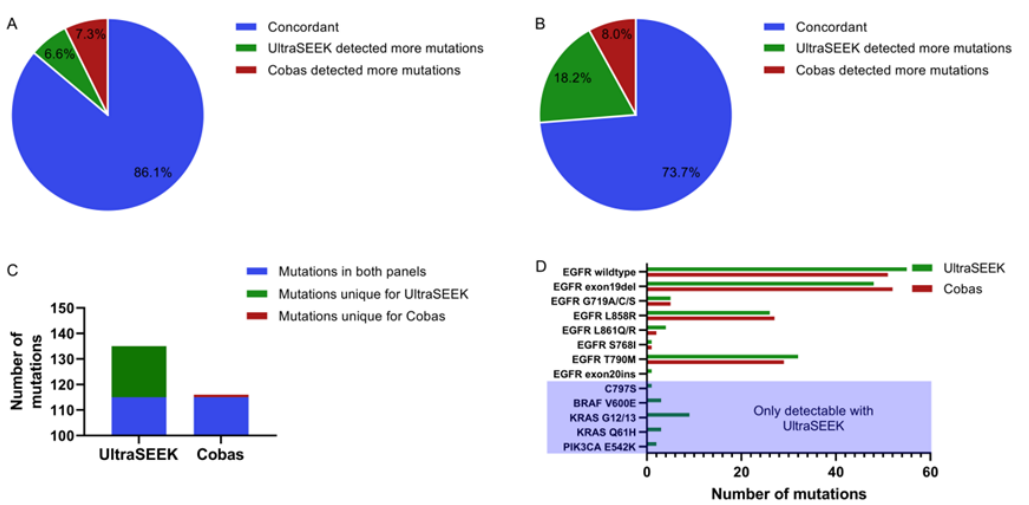
Figure 1. Comparison of mutation detection between UltraSEEK ™ and Cobas ® . Pie charts representing the samples which were concordant between UltraSEEK ™ and Cobas ® (blue), samples in which UltraSEEK ™ detected more mutations (green), and samples in which Cobas ® detected more mutations (red) for ( A ) the mutations detectable on both panels and ( B ) all clinically relevant mutations across BRAF , EGFR , KRAS , ERBB2 and PIK3CA . ( C ) Bar graph illustrating the total amount of mutations detected in all 137 samples. The blue bar represents the number of mutations that could